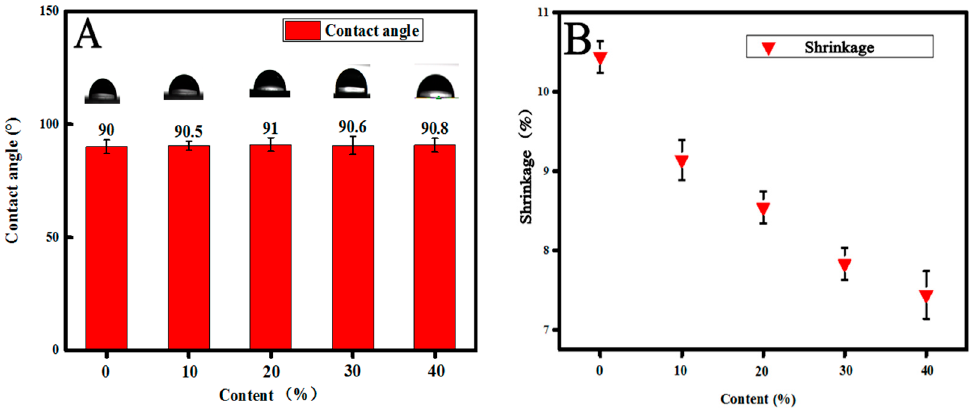
Figure 2. Influence of the modification ratio on the water contact angles and polymerization shrinkage of the UV-cured polymer. (( A ), contact angles of samples with di ff erent contents of epoxy; ( B ), Shrinkage of samples with di ff erent contents of epoxy). Table 1. The shrinkage of the samples with different content of epoxy resin.